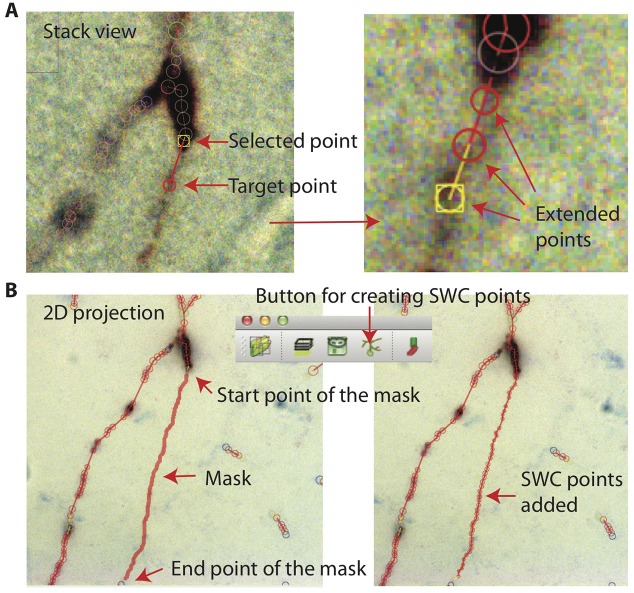
Creating SWC points. (A) In Stack View, an SWC point is selected. Find the target point by finding the focus plane of the branch. Clicking on the target point creates SWC points connecting the target point to the selected point along the branch. (B) In Projection View, pressing r starts mask creation. Click on the starting point and Shift-click on the end point along a branch creates a mask. Clicking on the Mask → SWC button creates SWC points along the mask.